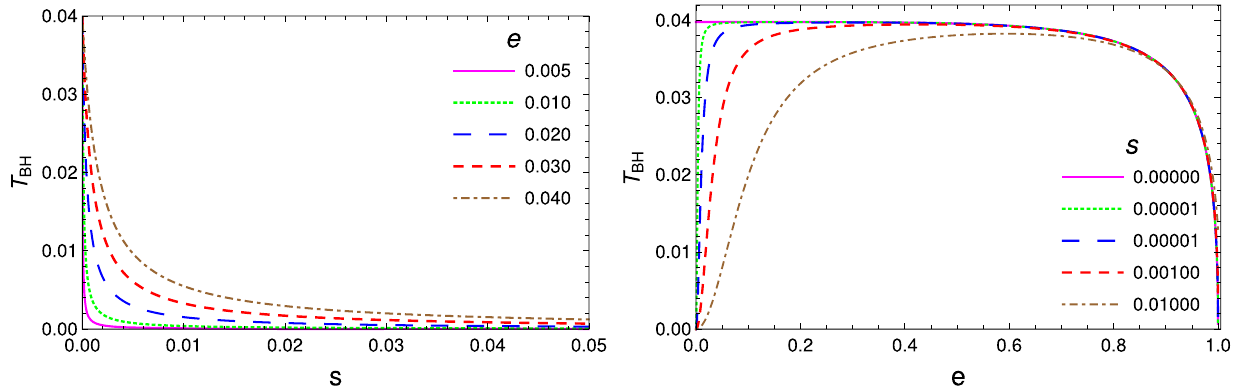
Fig. 1 (Left) Plot of the Hawking temperature T BH of the scalar-hairy RN black hole with respect to the scalar charge s for different values of the electric charge e with M ADM = 1. (Right) Plot of the Hawk-